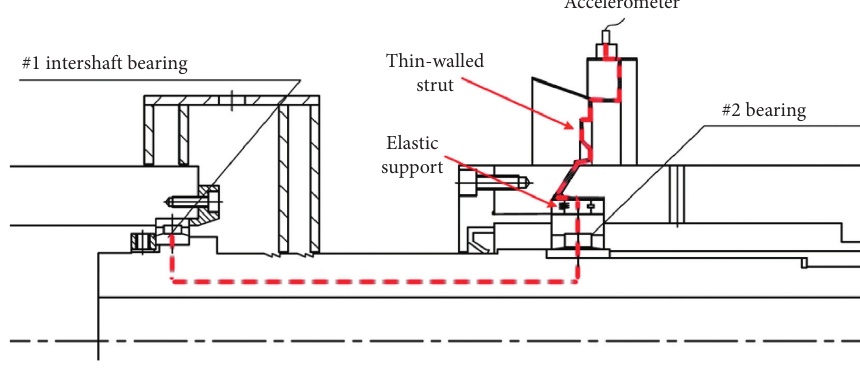
Figure 16: Transfer path of vibration signal of #1 intershaft bearing.